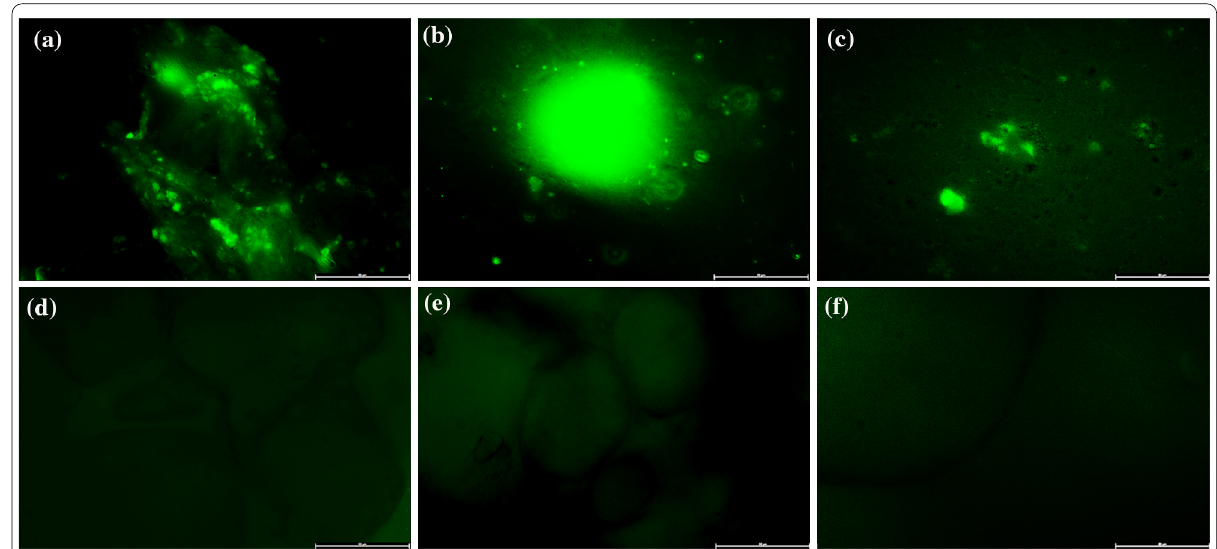
Fig. 2 Fluorescence images of P. aeruginosa PAO1 biofilm developed in porcine skin explant wells. a – c Porcine skin explants incubated with PAO1 for 24 h, 48 h, and 72 h, respectively; d – f porcine skin explants incubated with LB medium as negative controls for 24 h, 48 h, and 72 h, respectively. Scale bars are indicated in 50